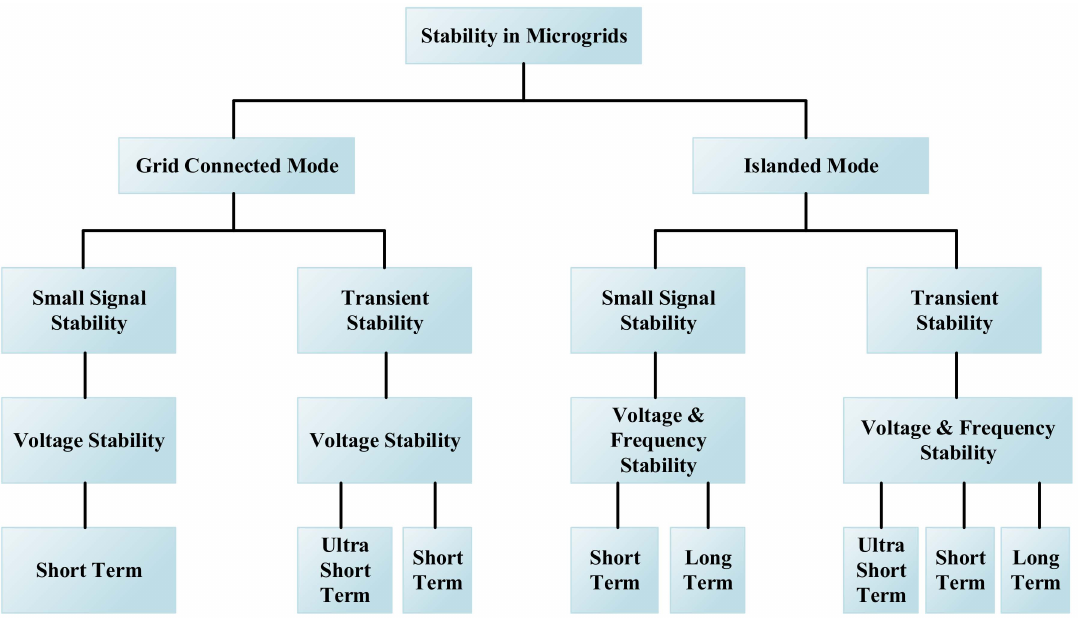
Figure 4. Methods for stability in